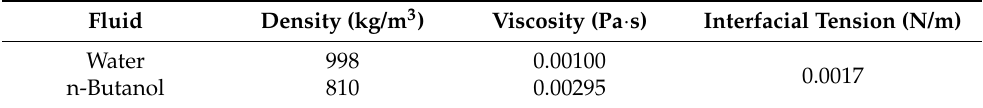
Table 1. Fluid properties of water and n -butanol at 20 ◦ C.